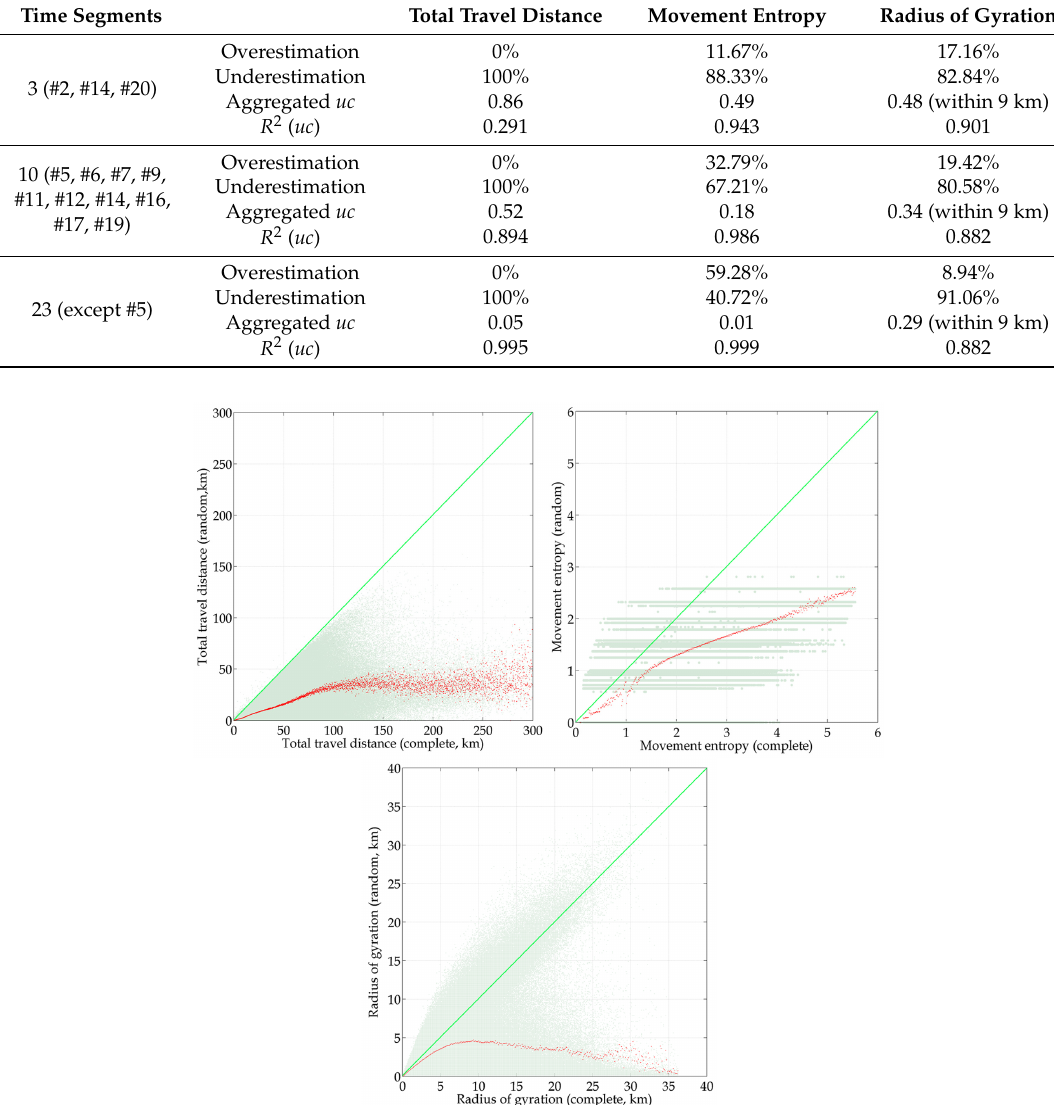
Table 2. Mobility indicator statistics for different random time segments.